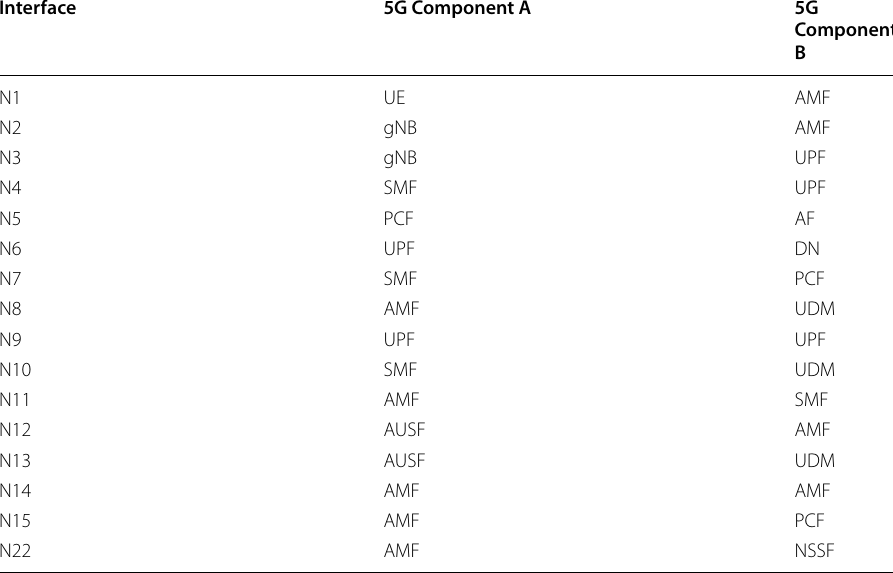
Table 1 Standardised 5G